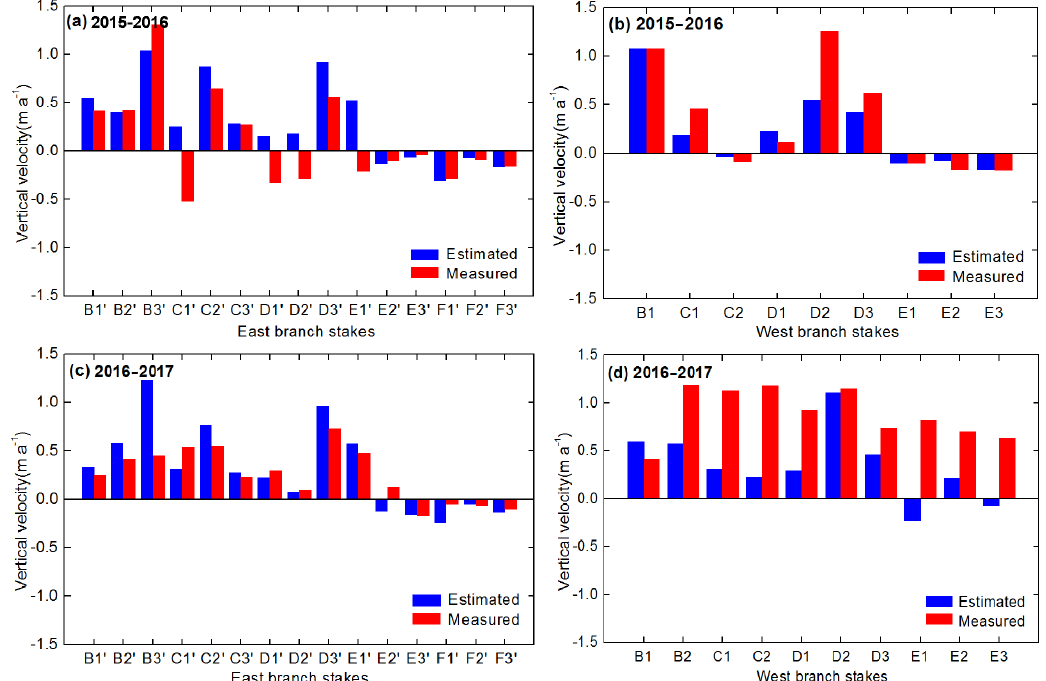
Figure 8. Comparison between estimated and in situ measured vertical velocity for the mass-balance year 2015–2016 and 2016–2017; the letters represent ablation stakes (Fig. 1). Note that the summer periods and stakes in the higher elevations were not selected for comparison due to snow cover reduced the quality of in situ measured vertical